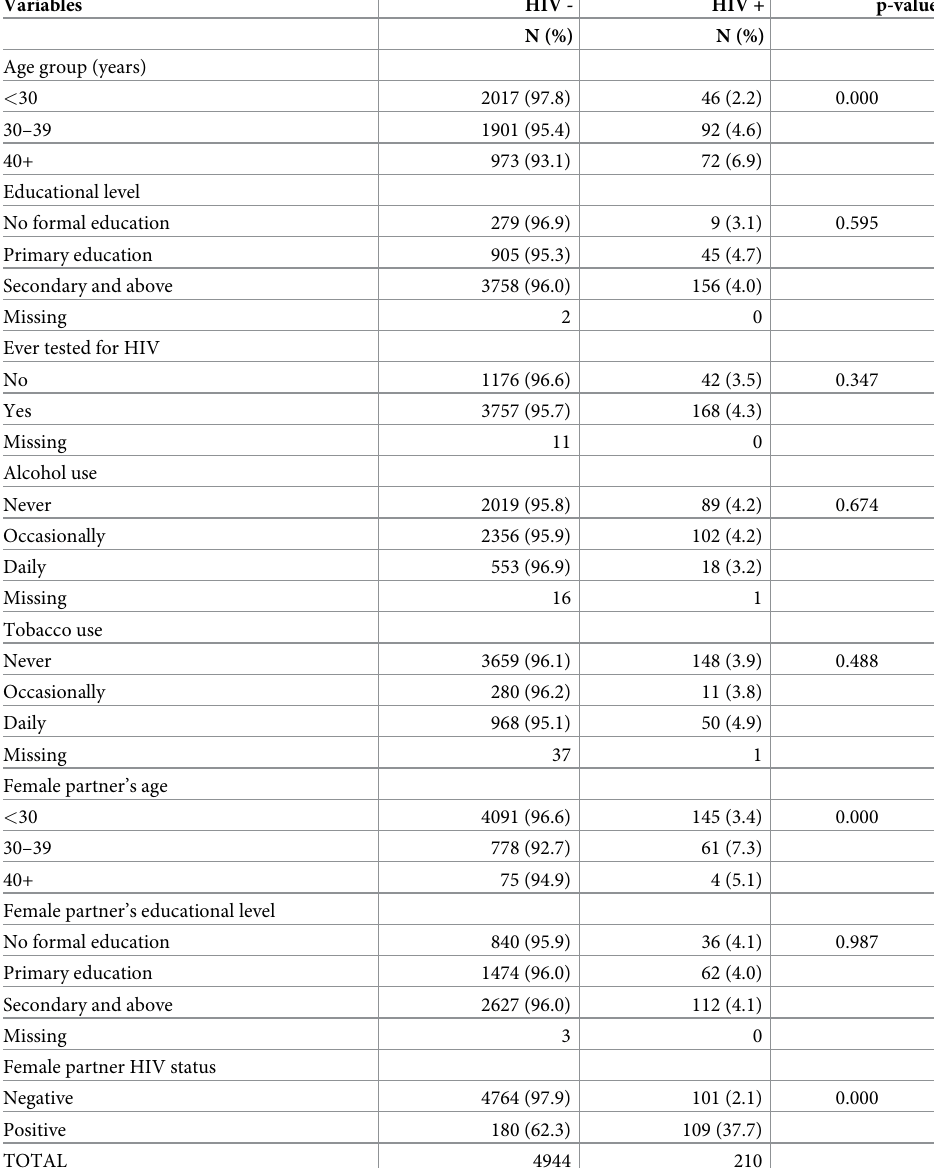
Table 3. Comparison of characteristics of male partners of pregnant females in HBI in Benue State, Nigeria by HIV status. Variables HIV - HIV +